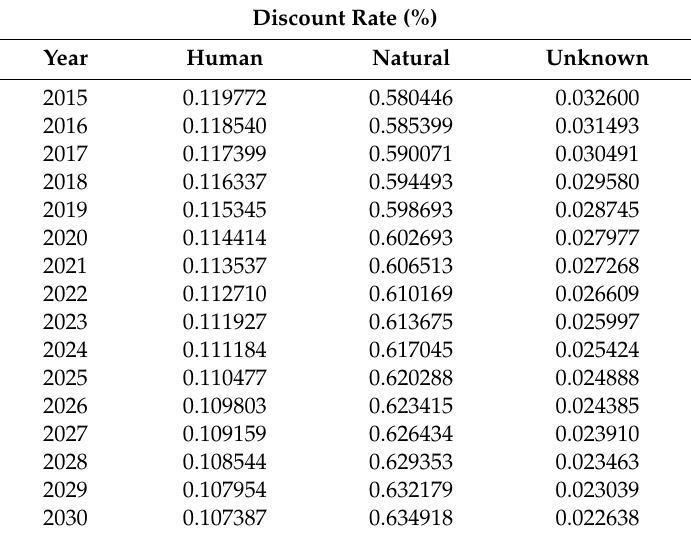
Table 7. Discount rates per cause for the period 2015 to